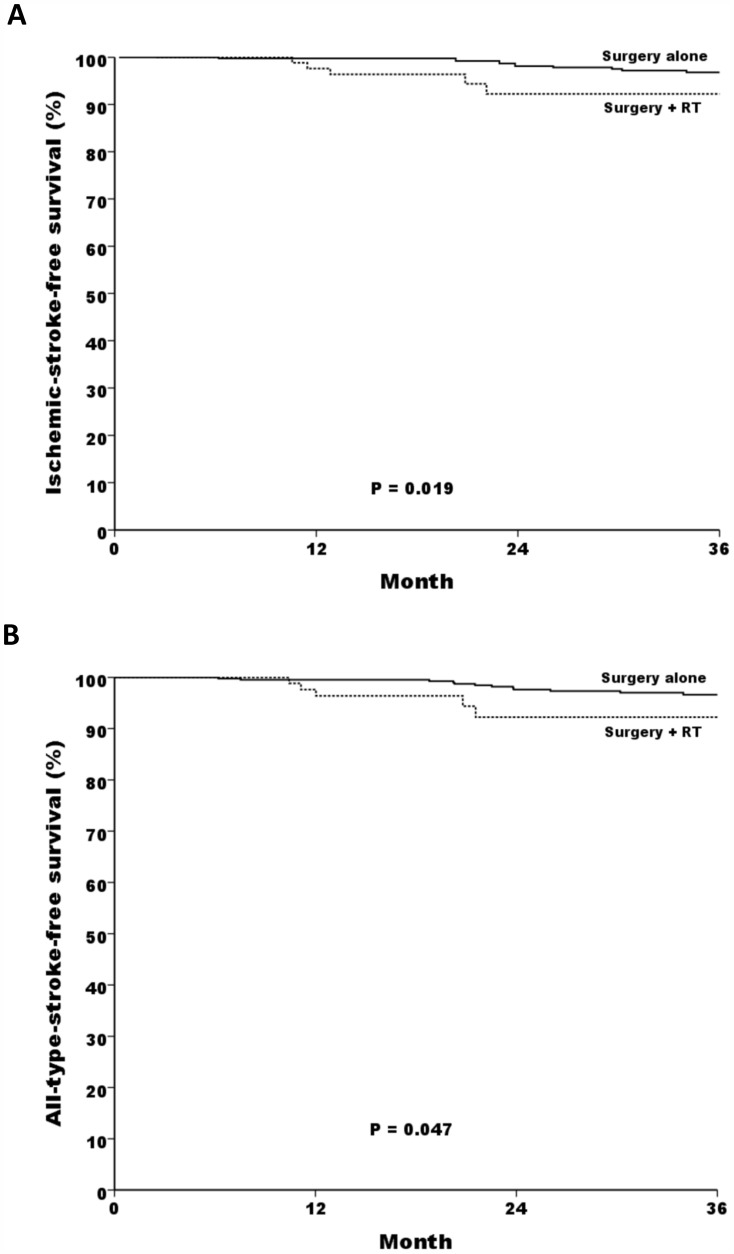
Kaplan-Meier estimates of 2-year stroke-free rates according to treatment groups (surgery-plus-RT versus surgery-alone).
Panel 2A, ischemic-stroke-free rates: 92.2% versus 98.1%, P = 0.019; and Panel 2B, all-stroke-free rates, 92.2% versus 97.6%, P = 0.047.